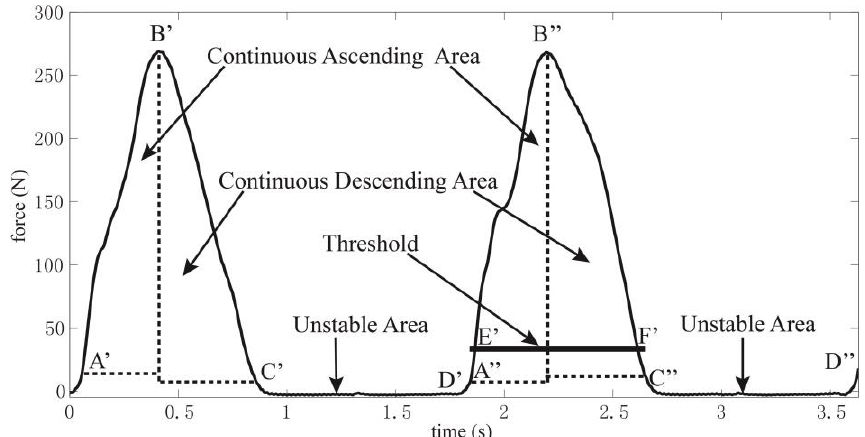
Figure 7. Using different P F gains for threshold computation. The line marked in blue is the GCFs detected to be in unstable area. The lines marked in red and green are the computed threshold using two different P F values. ( a ) The original signal analysis, ( b ) The exaggerating signal analysis for better demonstration. Table 1. Rule of gait pattern detection. Heel